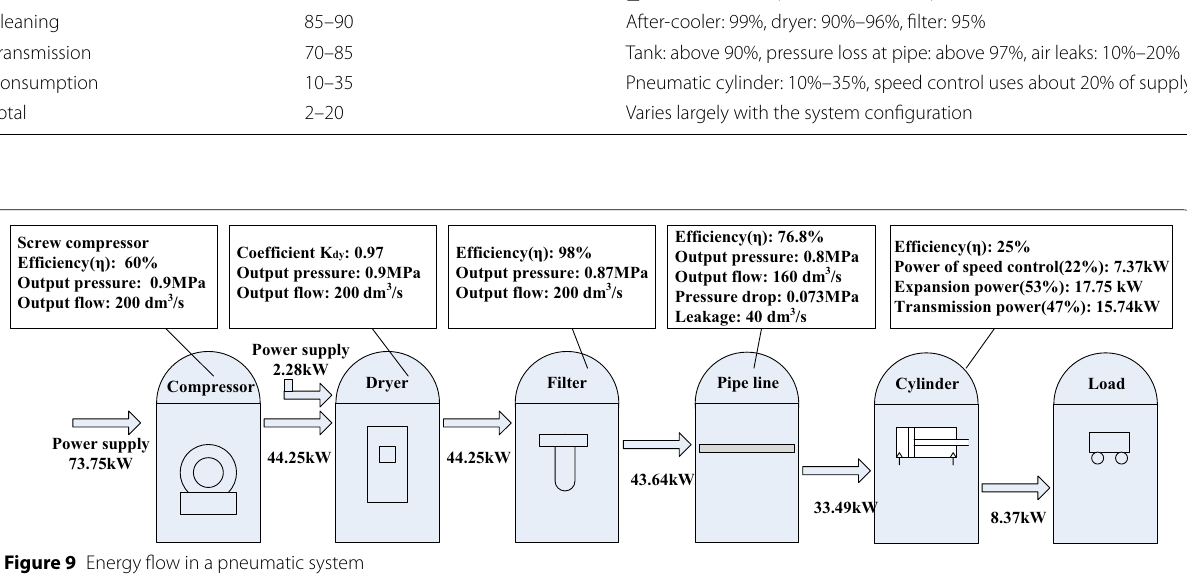
Figure 9 Energy flow in a pneumatic system